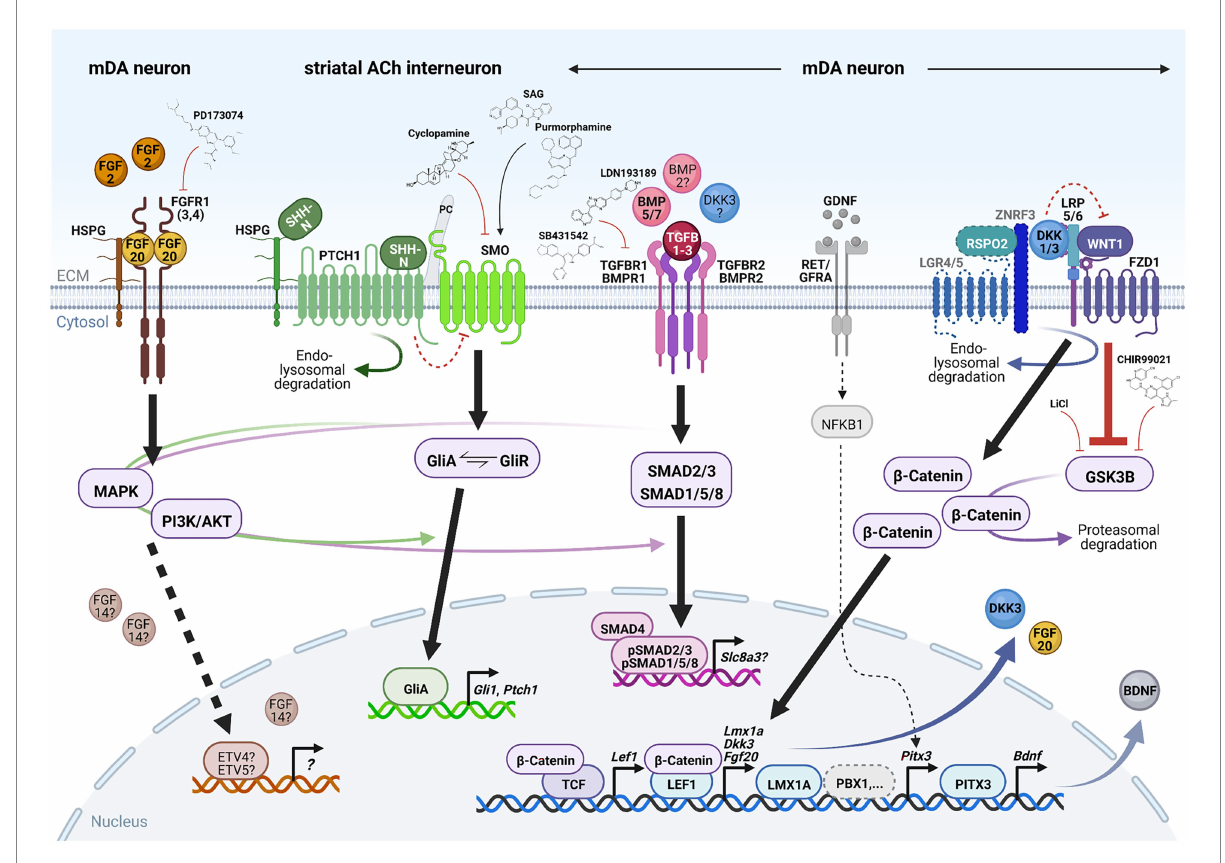
FIGURE 4 Signaling pathways required for mDA neuron survival in the adult, aging or lesioned mammalian VM. Simplified schematic depiction of the FGF (brown), SHH (green), TGFb/BMP (pink) and WNT/b-catenin (blue) signaling pathways and TFs or transcriptional targets implicated in the adult survival and protection of mDA neurons. FGF, TGFb/BMP and WNT/b-catenin signaling take place in the mDA neurons themselves, whereas SHH signaling is not active in these neurons but in one of their striatal target cells [cholinergic (ACh) INs]. The simplified GDNF/RET/GFRa signaling complex (gray) has been added for clarity in this context. Small molecules frequently employed to activate or inhibit the corresponding pathway are also indicated. Arrows indicate activation, red crossbars indicate inhibition of the corresponding pathway or target gene/protein. Stippled lines label pathways or signaling components not yet demonstrated in adult mDA neurons. Question marks denote still unclear target genes, TFs or ligands for the corresponding pathway during mDA neuron maintenance. See text for details and abbreviations. Created with